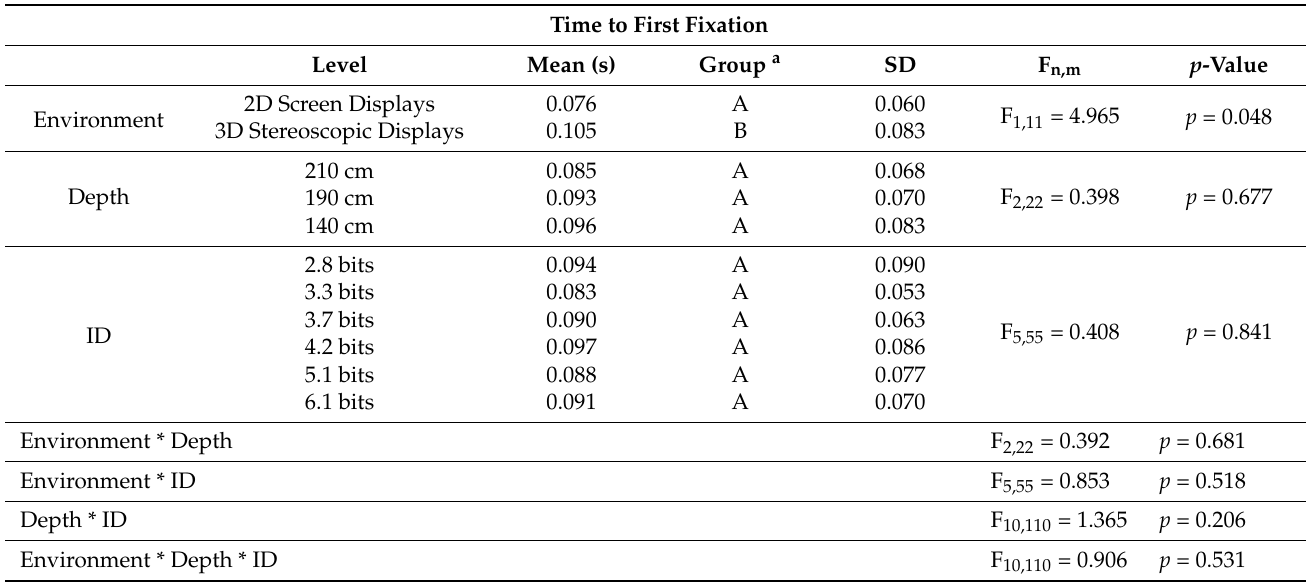
Table 6. Means, SDs, ANOVA, and Tukey HSD test results of time to first